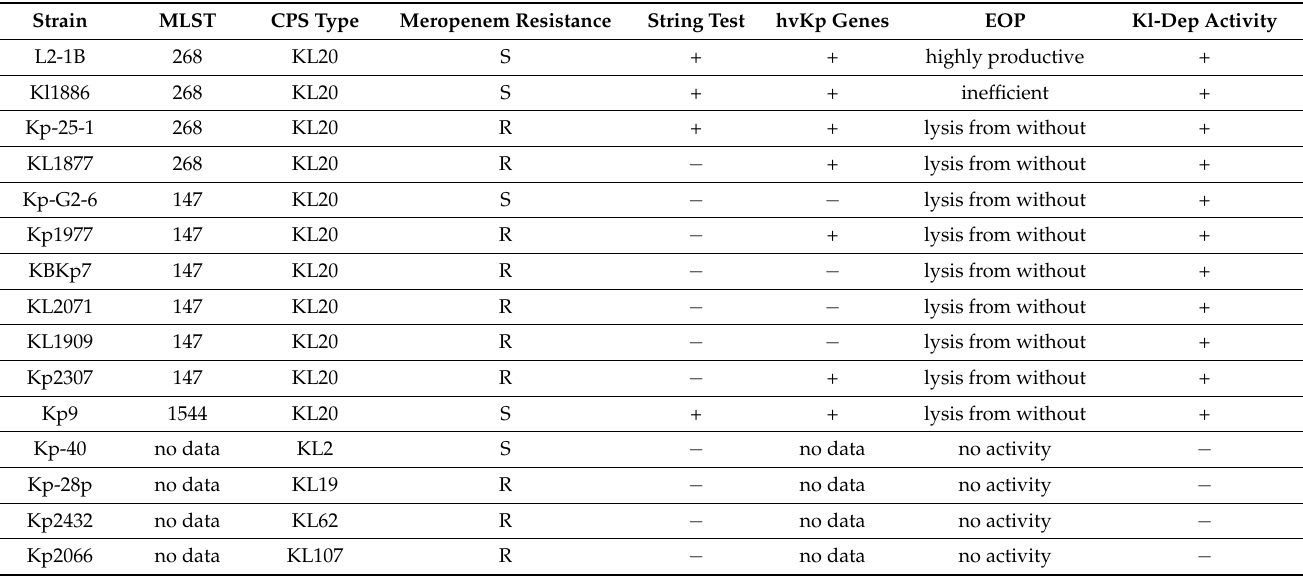
Table 1. Characterization of K. pneumoniae strains and the activity of the vB_KpnP_Klyazma phage and its recombinant depolymerase.